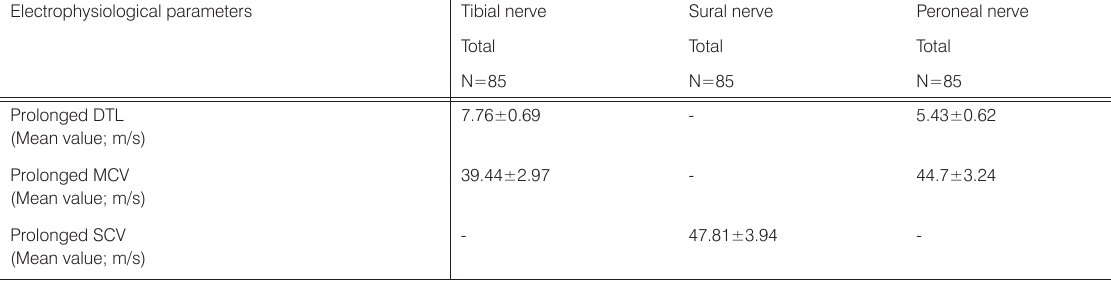
Table 4. Mean values of evaluated electrophysiological parameters Electrophysiological